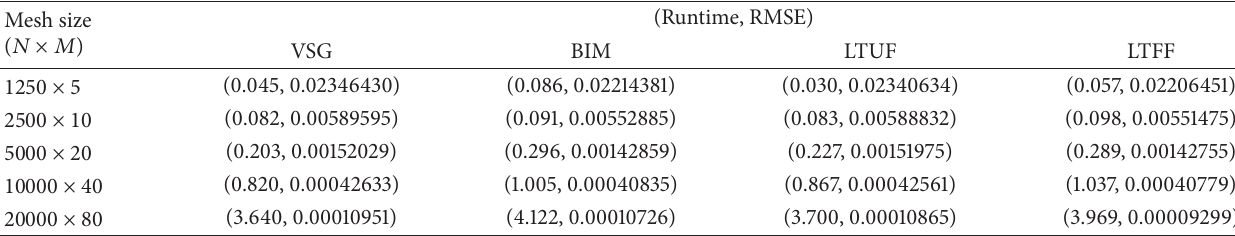
Table 2: Comparison of RMSE and runtime in the solution.